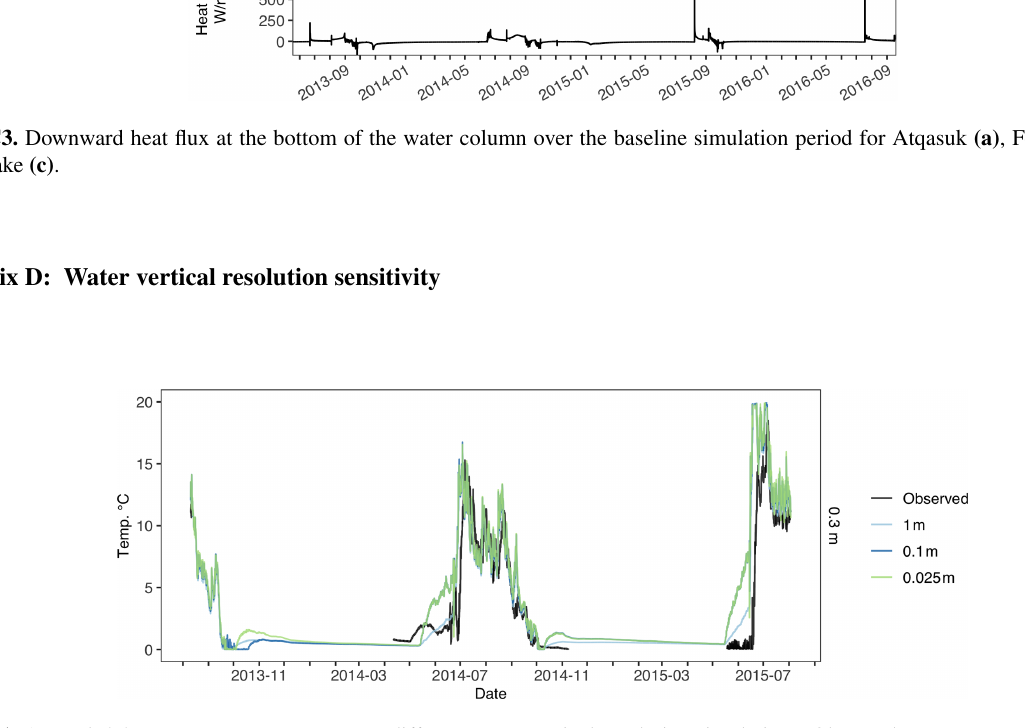
Figure D1. Atqasuk 0.3m water temperature across different water vertical resolution simulations. Observed water temperature is in black, 1m vertical resolution is in light blue, 0.1m vertical resolution is in blue, and 0.025m vertical resolution is in green. Note that 0.1 and 0.025m overlap for most of the time